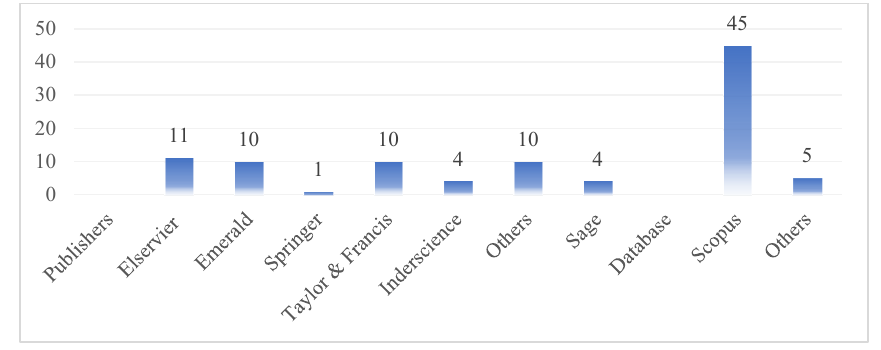
Fig. 2. Distribution of journal papers by publishers and database